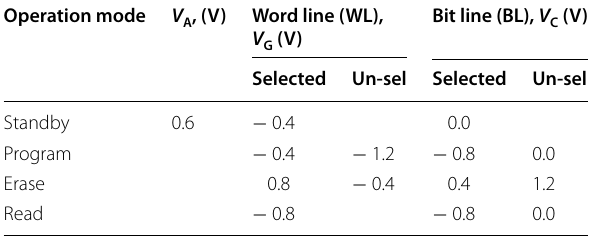
Table 1 Operating voltage condition of 3‑T TRAM array Operation mode